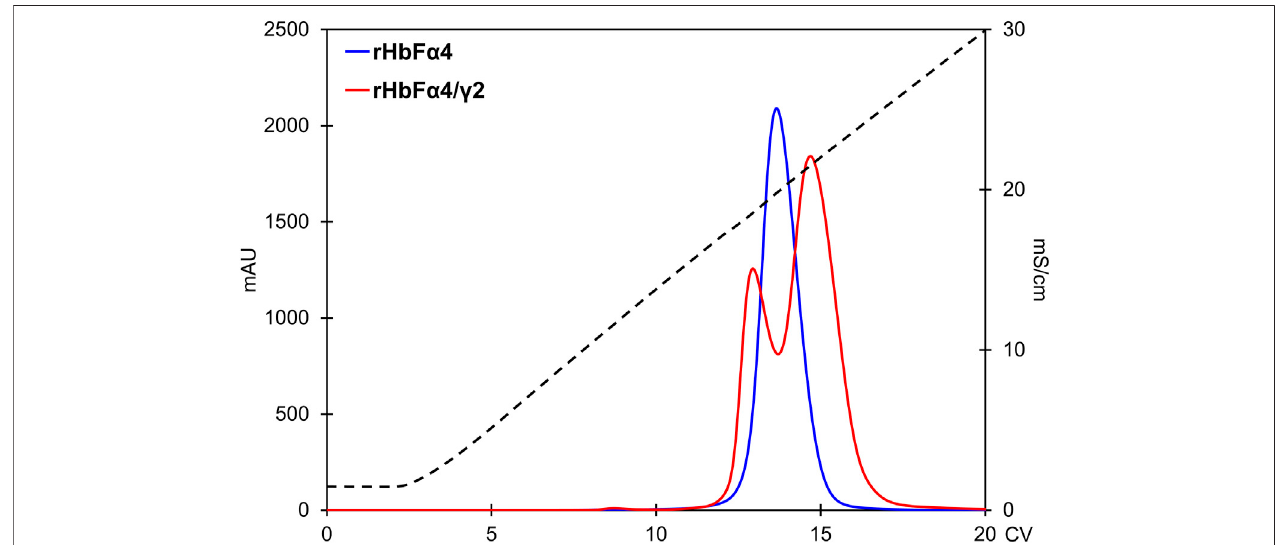
FIGURE 6 | Comparison of the rHbF α 4 (blue) and rHbF α 4/ γ 2 (red) elutions during Q HP separation (in this example no extra wash step was used in the capture column TREN prior to the Q HP). The rHbF α 4 sample elutes as one homogenous peak, while rHbF α 4/ γ 2 display two peaks. In the rHbF α 4/ γ 2 fractions, the fi rst peak showedhemichromespectrumwhenchallengedwithK 3 [Fe(CN) 6 ]andthesecondpeakdisplayedtheexpectedferricspectrumindicatingfunctionalbehavior.Thus,the rHbF α 4/ γ 2 mutant yield of functional Hb was much less than anticipated from the crude extract calculation, as the sample contained diverse Hb